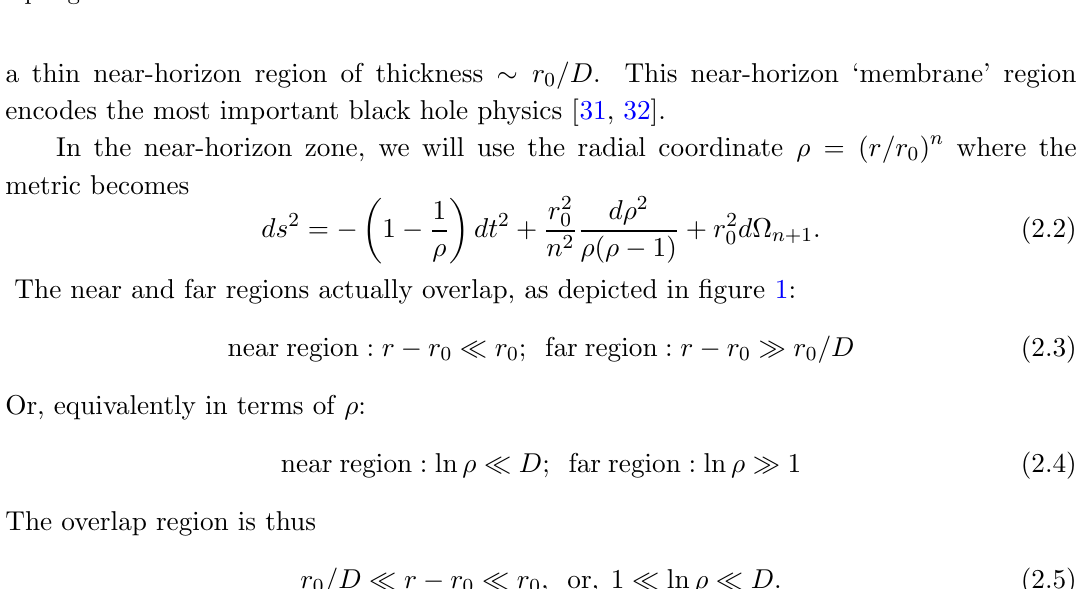
Figure 1. A schematic diagram representing the range of the near-horizon, far zone and over- lap